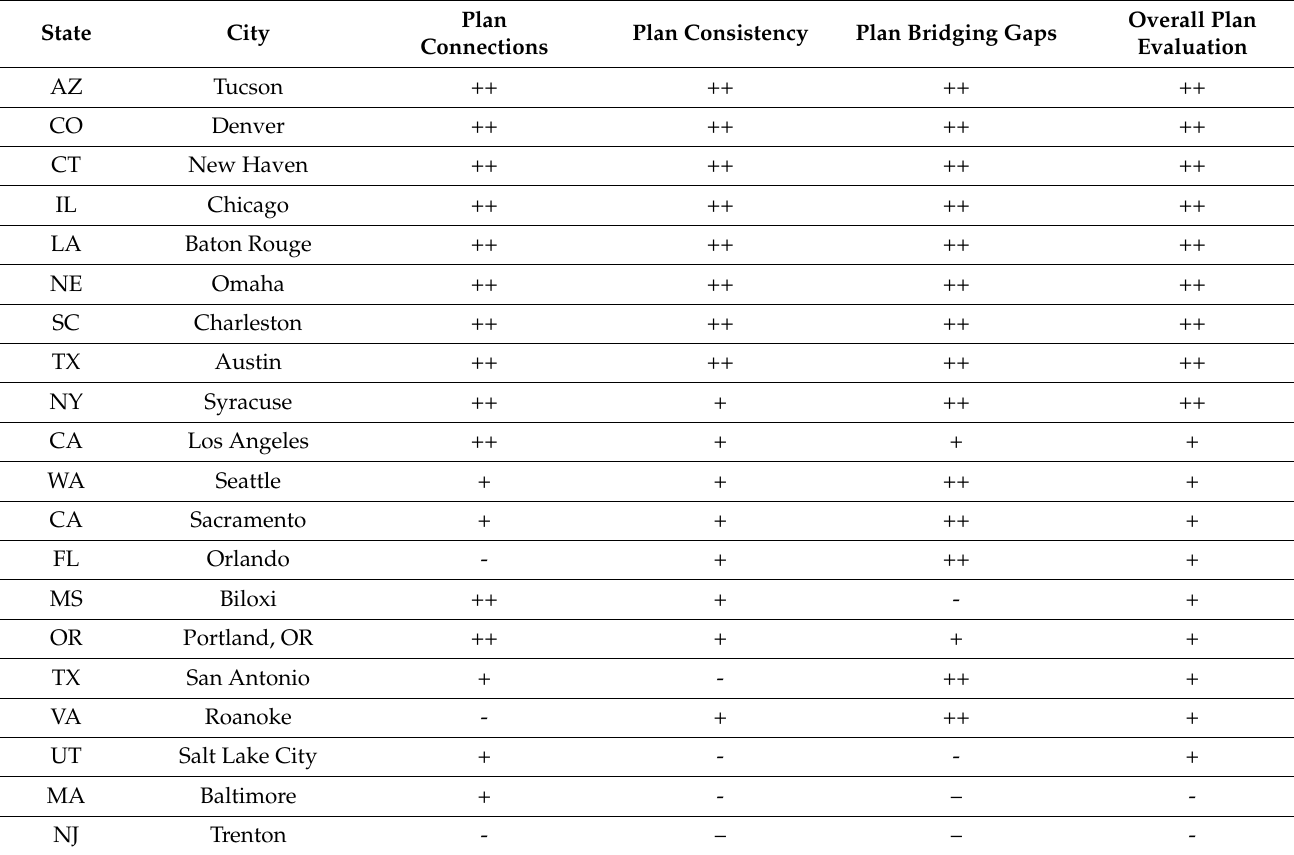
Table 2. Evaluations of the 20 city plans that use the constellation